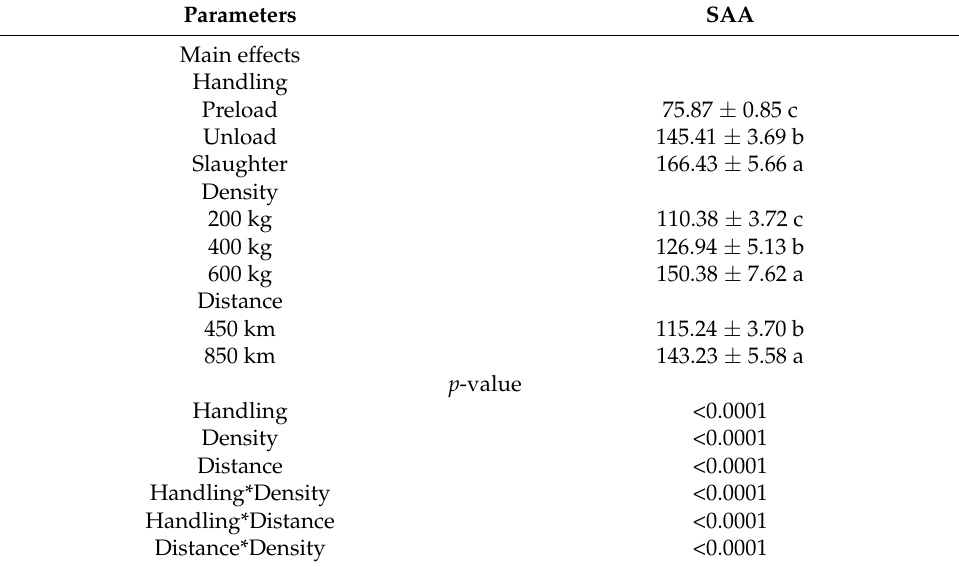
Table 8. Serum amyloid A (SAA) as affected by handling, stocking density, and distance in road transported cattle.